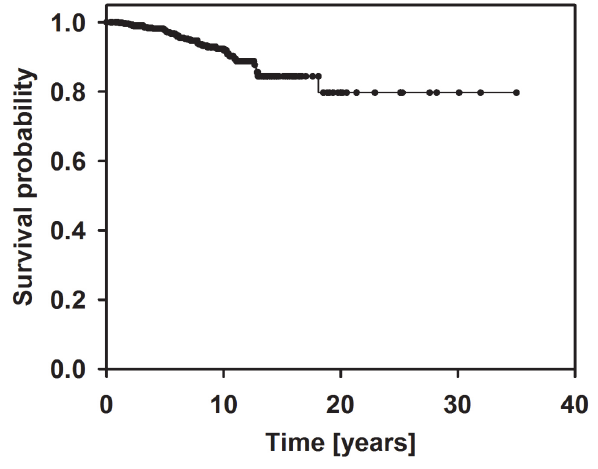
Fig. 2. Kaplan-Meier survival